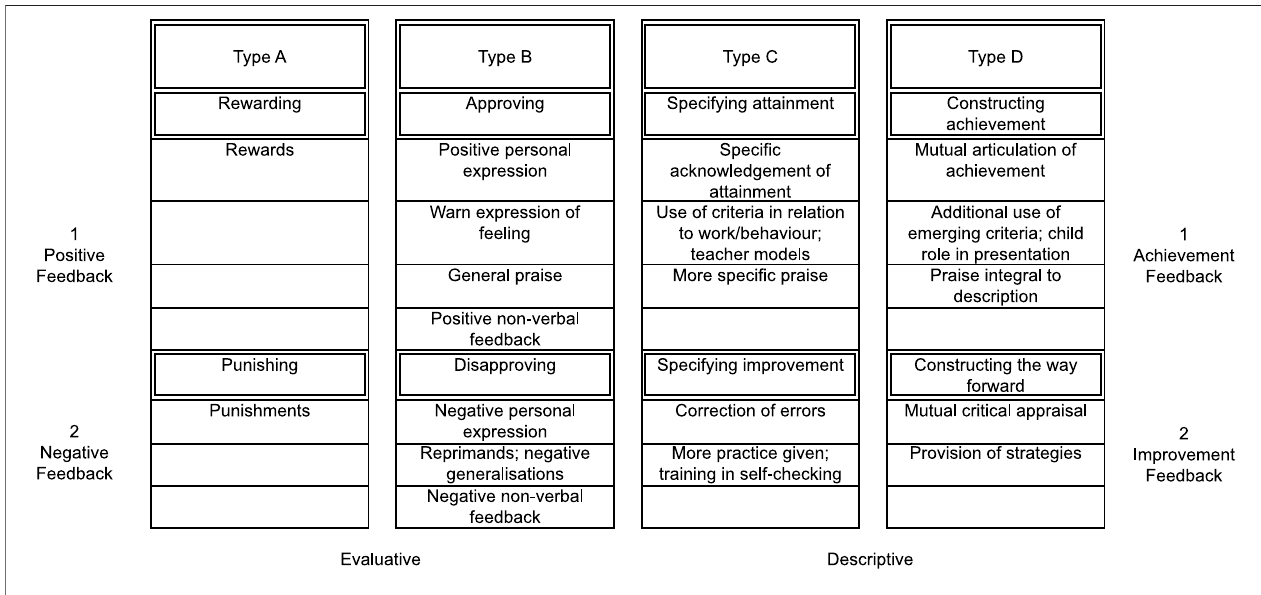
FIGURE 7 | Feedback typology by Tunstall and Gipps (1996).